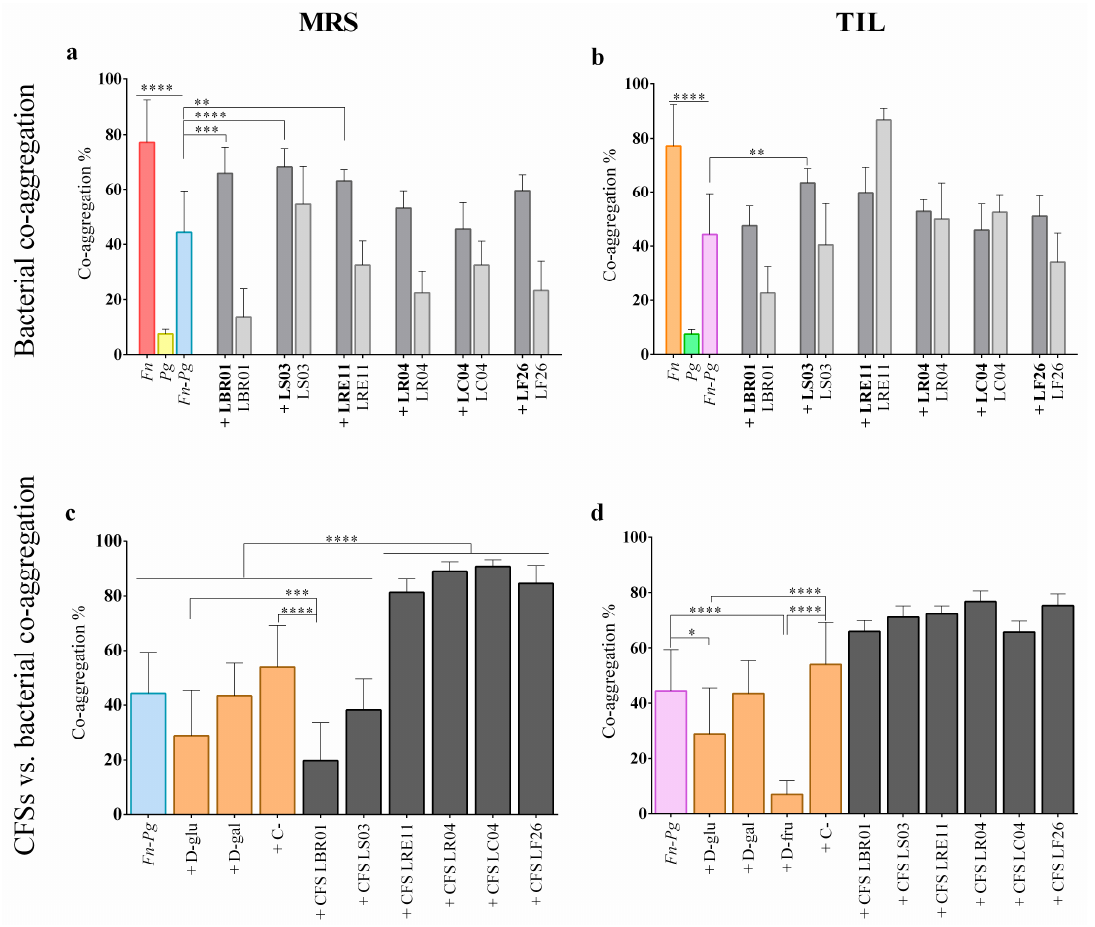
Figure 5. Auto- and co-aggregation assay executed with pathogens and probiotics grown in MRS ( a ) and TIL ( b ). The probiotic strain code alone refers to auto-aggregation; if a “+” before the probiotic strain is present, it means that the probiotic was added to the three-pathogen mix. CFS effects on the three-pathogen co-aggregation in MRS ( c ) and TIL ( d ). All data are represented as the mean of three independent experiments ± SD. * p < 0.05; ** p < 0.01; *** p < 0.001; **** p < 0.0001. Fn = F. nucleatum ; Pg = P. gingivalis ; D-glu = D-glucose; D-gal = D-galactose; D-fru = D-fructose; C- = negative control; CFS = cell-free supernatant.